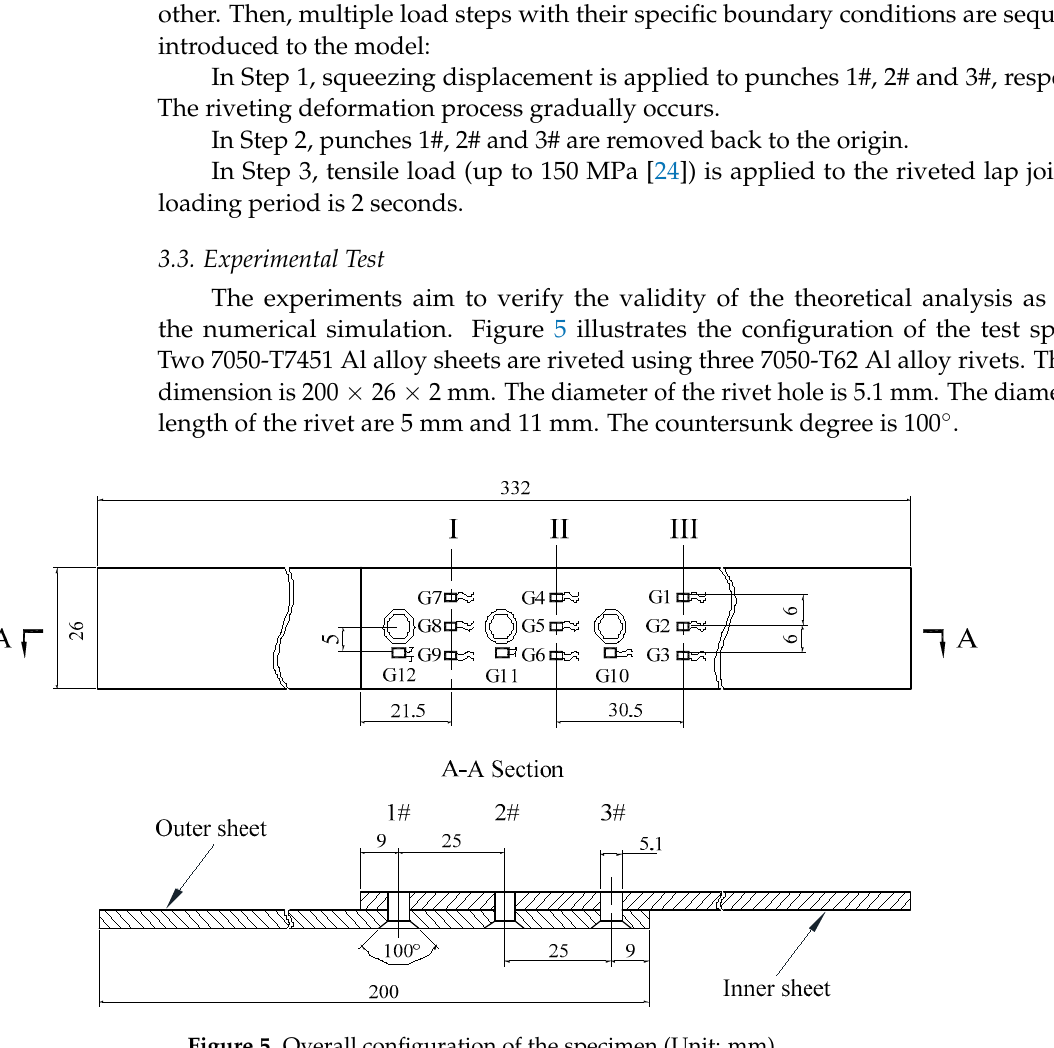
Figure 6. Multi-function testing machine. RCT-21KN Micro-strain gauges (Zhejiang University, Hangzhou, China) are em- ployed to capture the strain variations during the tensile test. The dimension of these gauges is 2 × 1.5 mm. All gauges are installed on the inner sheet (the driven head side), as shown in Figure 5. Gauges (G1~G9) are mounted at different parts (I~III) to measure the longitudinal strain variations associated with tensile load distribution. The deformation magnitude of the interface between each part is measured by G10, G11 and G12.